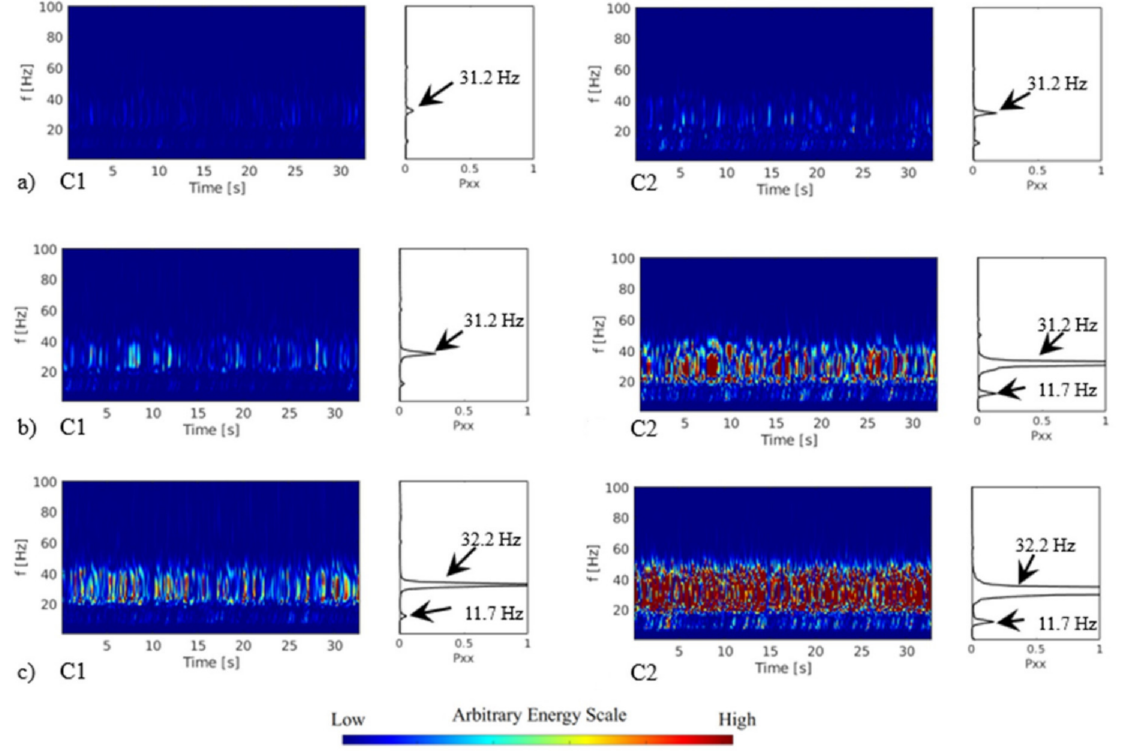
Figure 10. Continuous wavelet and Fourier spectrum of acceleration signals of the Case 14 with two cylinders free to vibrate: ( a ) reduced velocity = 35, ( b ) reduced velocity = 46, and ( c ) reduced velocity = 53.